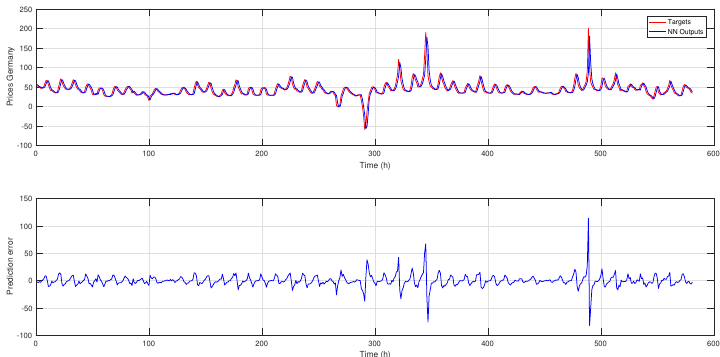
Figure 7. Energy price forecasting for Germany time series data.